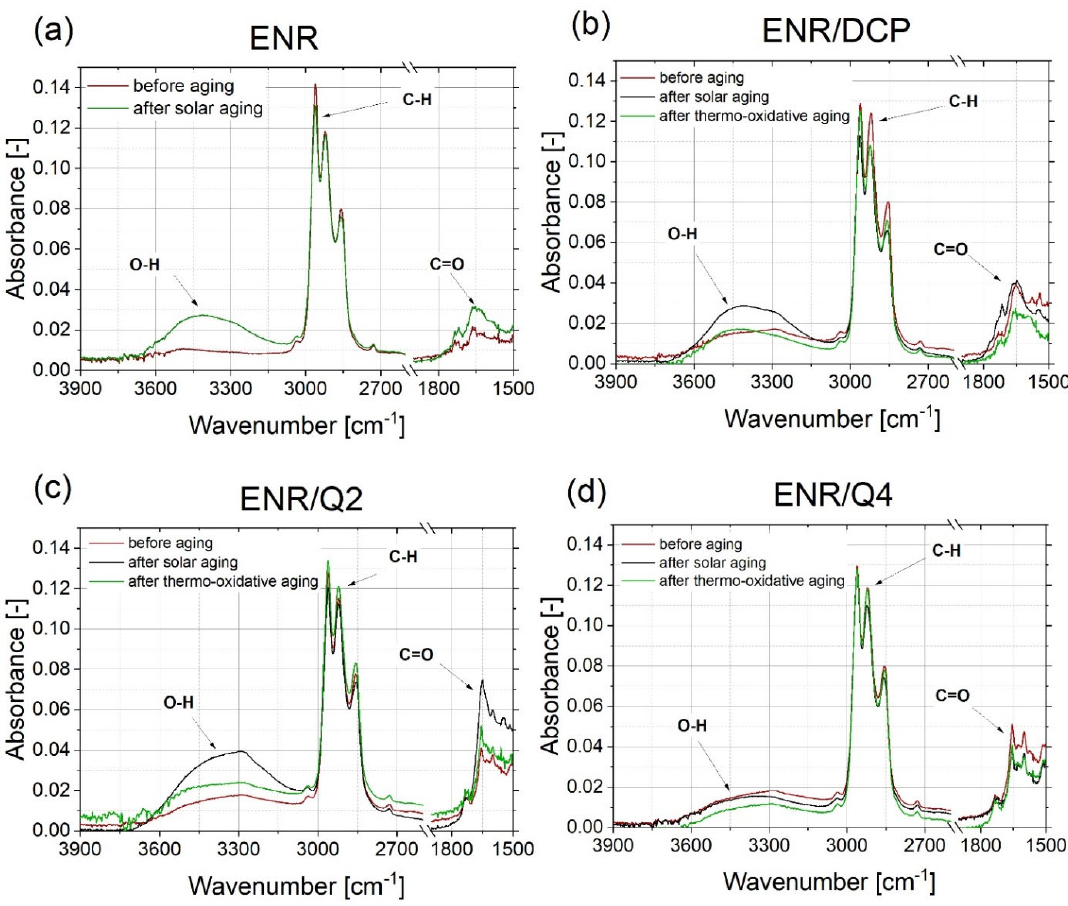
Figure 6. FT-IR spectra of uncured ENR ( a ), ENR cured with DCP ( b ), ENR cured with 2 phr of quercetin ( c ) and ENR cured with 4 phr of quercetin ( d ) before and after solar as well as thermo-oxidative aging.